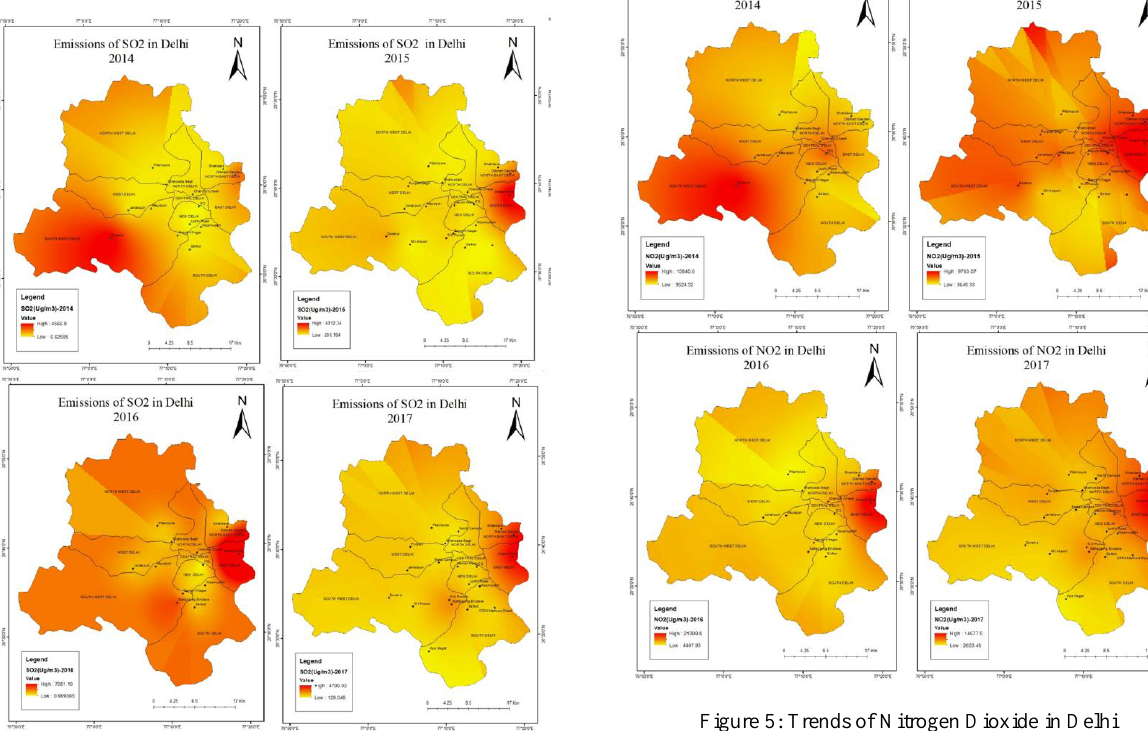
Figure 4: Trends of Sulphur Dioxide in Delhi